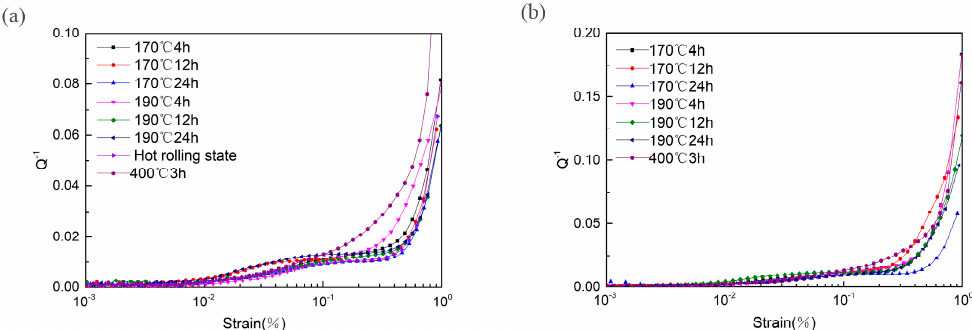
Figure 4. Damping-strain curve under different heat treatments. ( a ) T5 state; ( b ) T6 state.